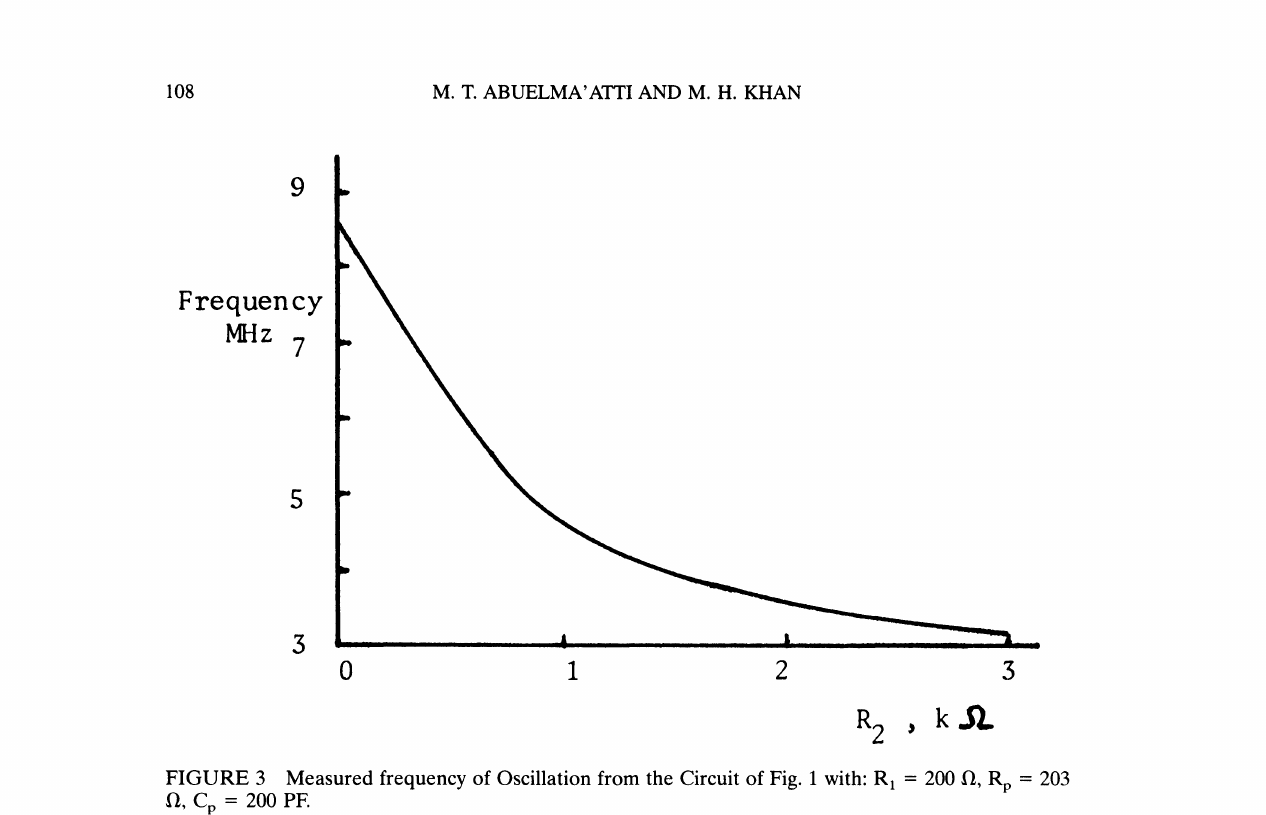
FIGURE 3 Measured frequency of Oscillation from the Circuit of Fig. with: R